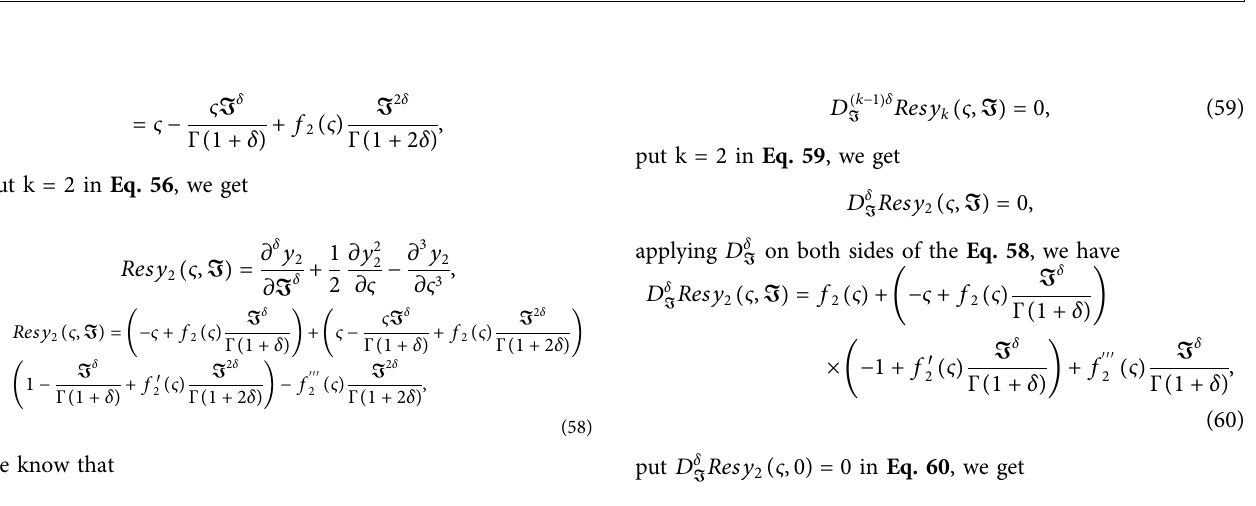
Frontiers in Physics |